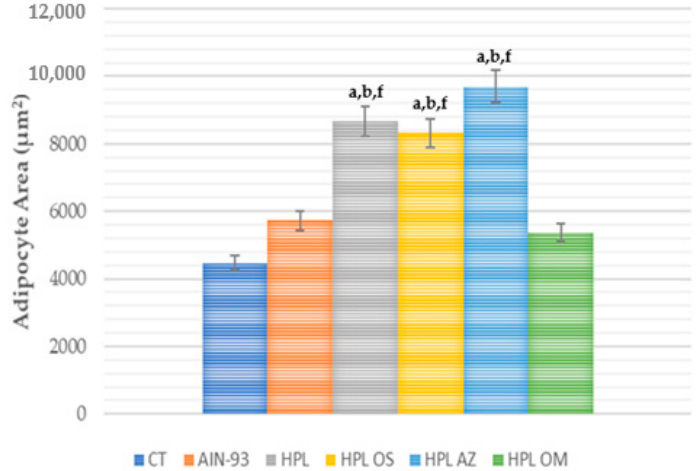
Figure 3. Adipocyte area ( μ m 2 ) of animals fed a balanced or high-fat diet and supplemented with saline, soybean oil, olive oil or seed oil of papaya ( Carica papaya Linn). Values expressed as mean ± standard deviation. The letters indicate statistical difference as follows: a compared to CT; b compared to AIN 93; f compared to HPL OM. p < 0.05. n = 6–11. ANOVA followed by Tukey post test.